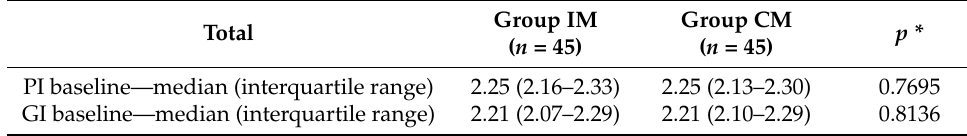
Table 3. Median (interquartile range) of PI and GI at baseline in all patients.